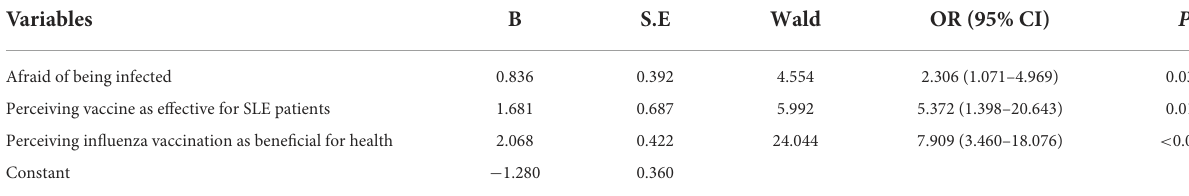
TABLE 5 Multivariate analysis of factors associated with willingness to get influenza vaccination among SLE patients. Variables